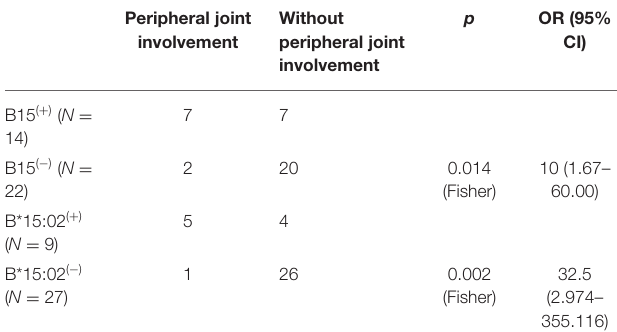
TABLE 6 | HLA-B15 and HLA-B * 15:02 had association with peripheral joint involvement in HLA-B27( − ) AS patients (step 2).